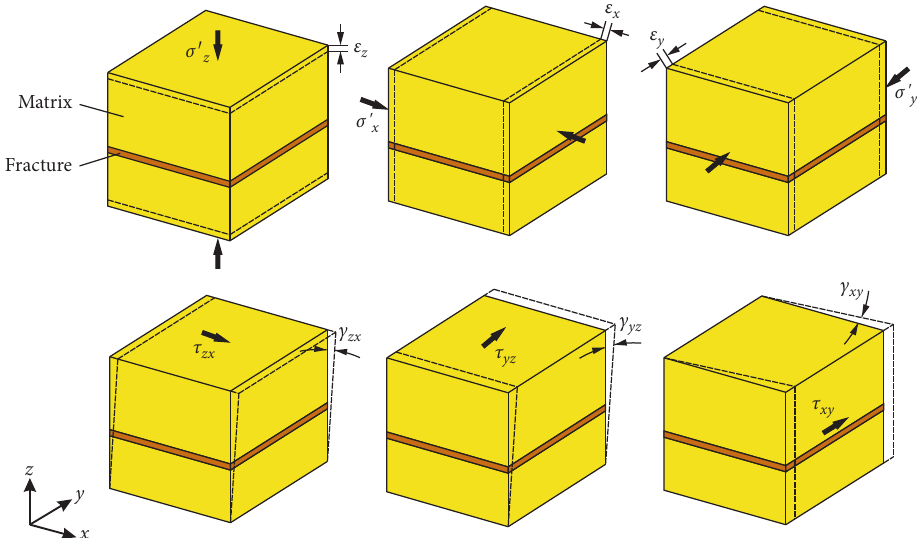
Figure 2: Illustration of stress-strain